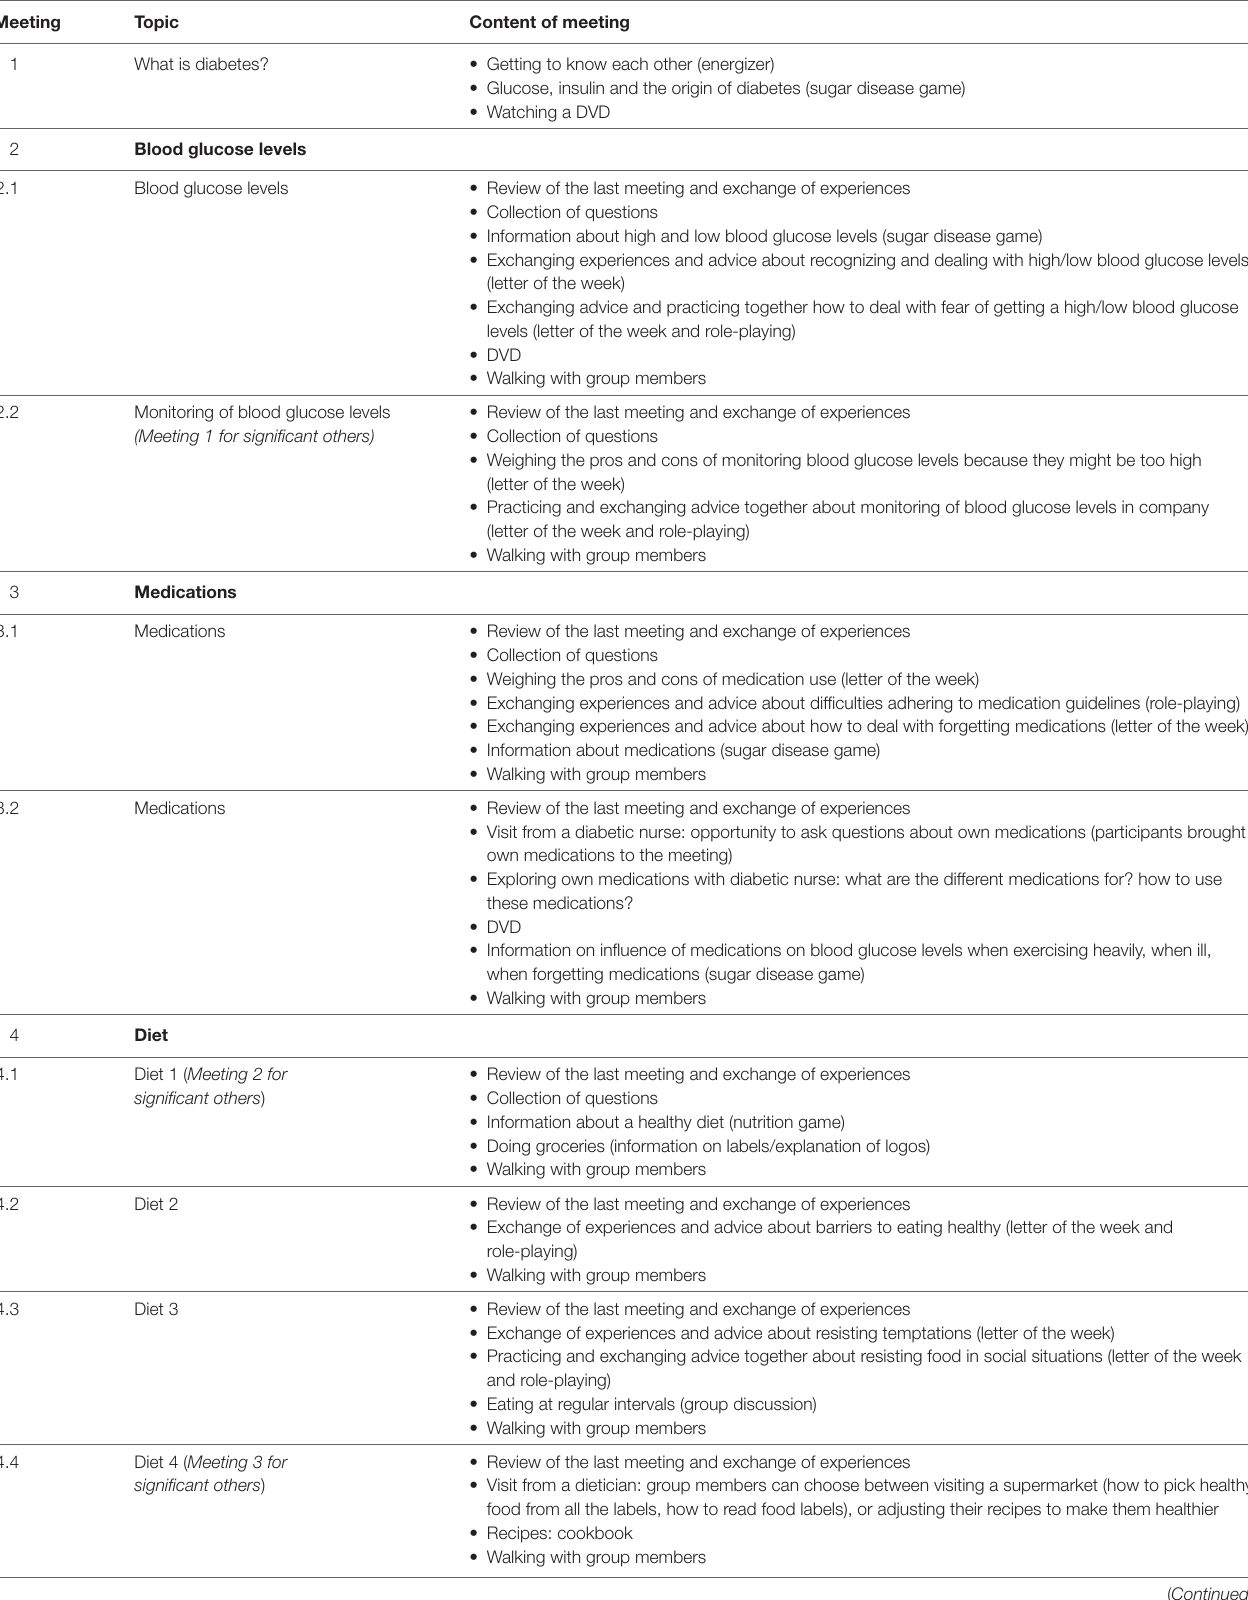
TaBle 2 | Overview of the topics in the meetings for participants: phase 1.